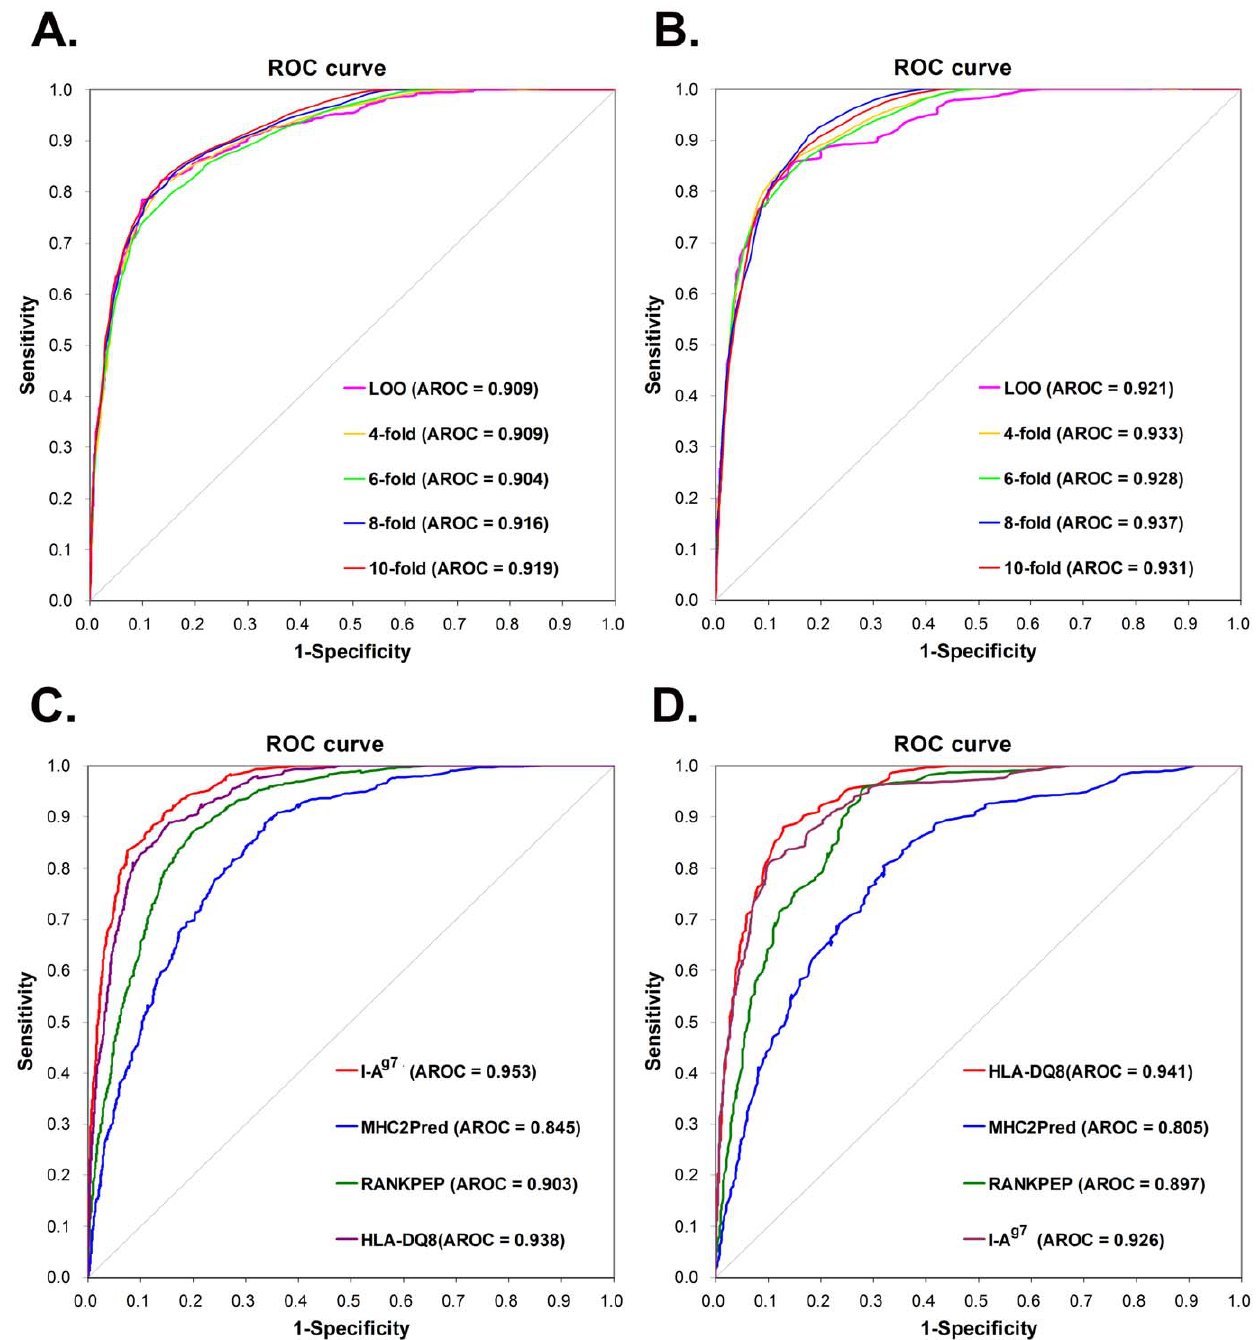
Figure 3.The performance evaluation of GPS-MBA 1.0 and a comparison with other approaches. The LOO validation and 4-, 6-, 8- and 10-fold cross-validations were performed for (A) mouse I-A g7 and (B) human HLA-DQ8, respectively. We compared the performance of GPS-MBA 1.0 with MHC2Pred and RANKPEP using the LOO validation for (C) I-A g7 and (D) HLA-DQ8, respectively. We also performed a cross-evaluation by using the HLA-DQ8 predictor in GPS-MBA to predict (C) I-A g7 epitopes and (D) vice versa